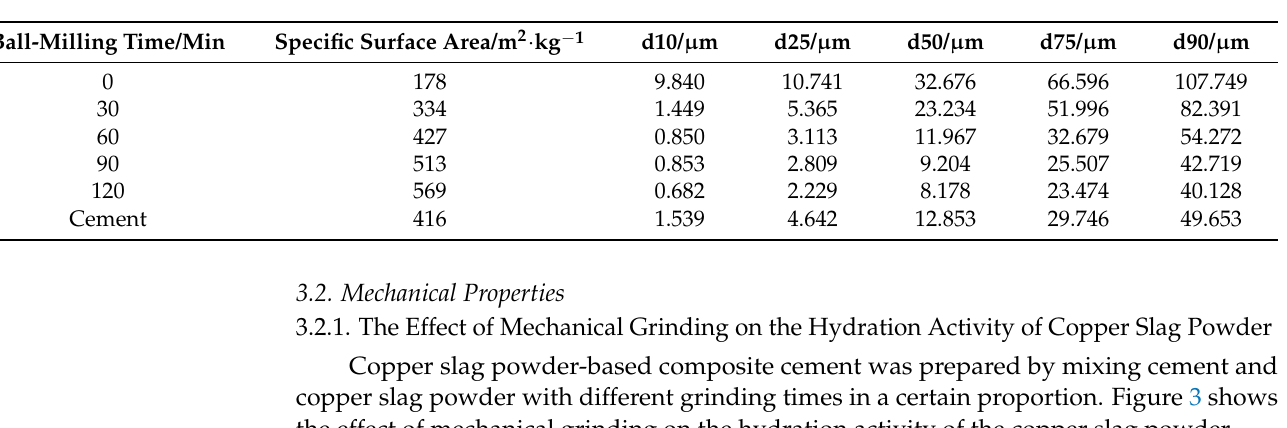
Table 4. Particle characteristics of cement and copper slag powder at different grinding times.